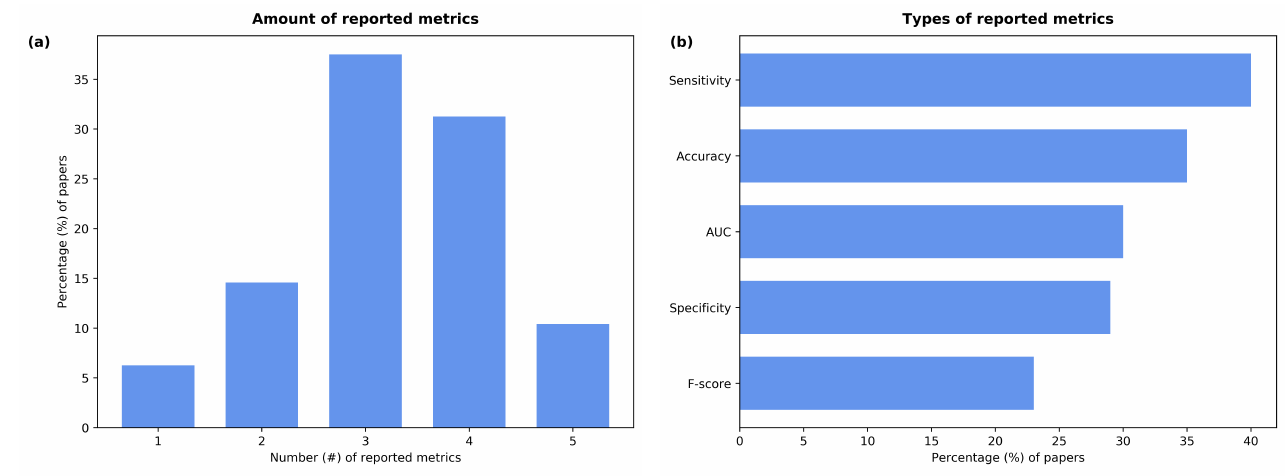
Figure 6. Percentage of papers that ( a ) reported the given number of metrics and ( b ) used each one of them.